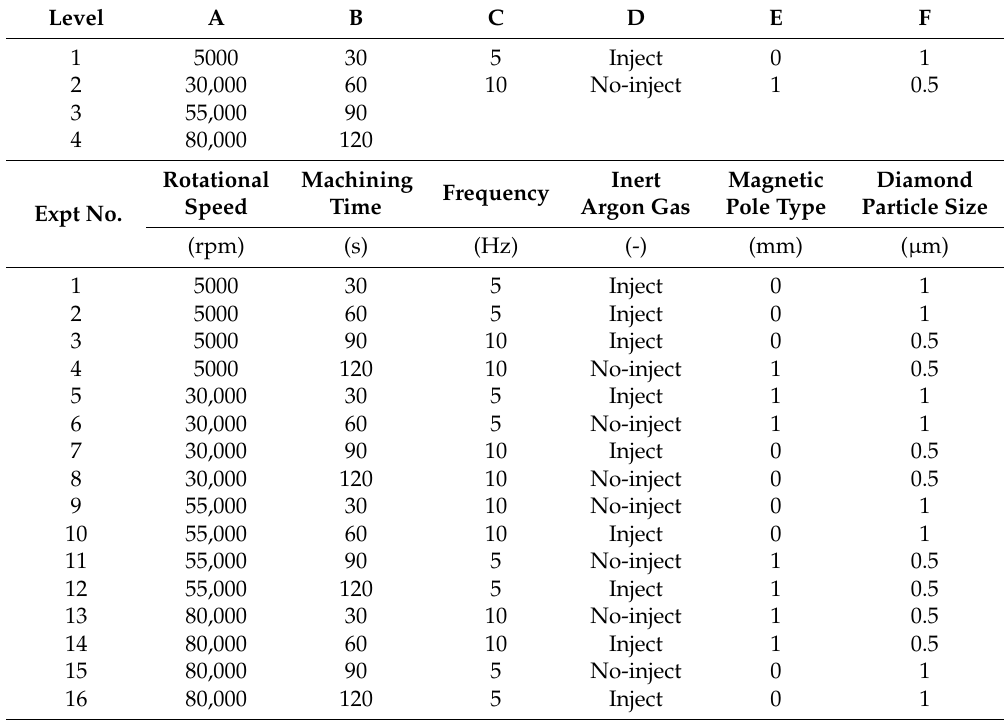
Table 2. Experimental